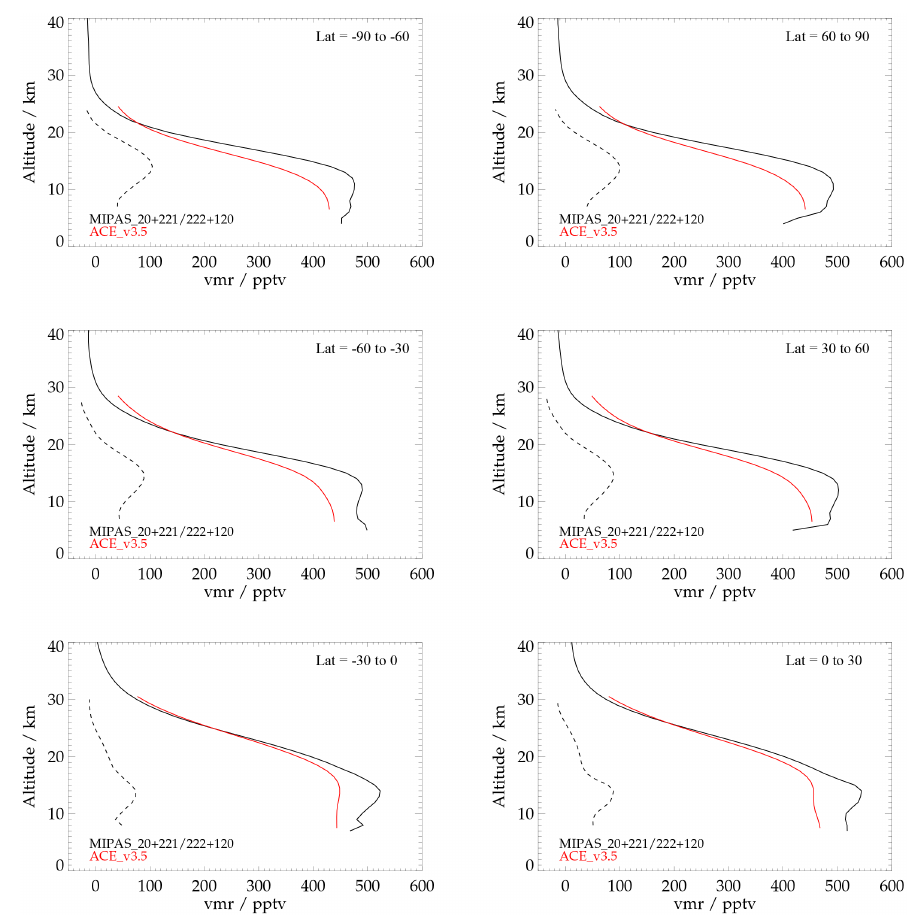
Figure 5. Comparison of OCS data obtained by MIPAS (solid black curves) and by ACE-FTS (v3.5) (red curves) in the latitude bands 60– 90 ◦ (top row), 30–60 ◦ (middle row) and 0–30 ◦ (bottom row), both for the Southern (left) and Northern Hemisphere (right). The displayed profiles are averages of collocated data in the respective latitude bands. For each ACE-FTS profile, MIPAS data within a maximum temporal offset of 5h and a maximum spatial distance of 500km were taken into account. Only ACE-FTS OCS data with quality_flag = 0 were used. The ACE-FTS profiles were convolved with the averaging kernels related to a MIPAS OCS retrieval. Dashed black curves are the differences between MIPAS and